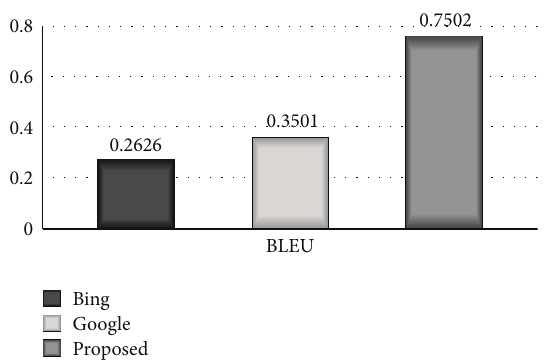
Figure 3: Comparative bar diagram between proposed system, Google, and Bing based on BLEU scale.